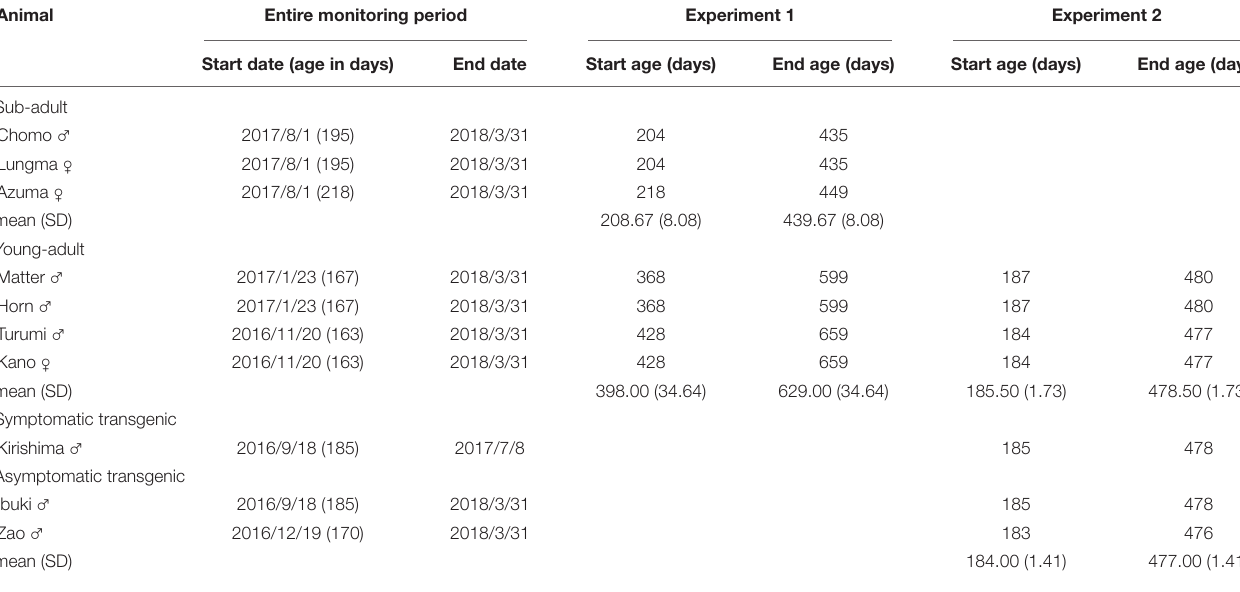
TABLE 1 | Period of study and age range for each marmoset participating in either Experiment 1 or Experiment 2 . Animal Entire monitoring